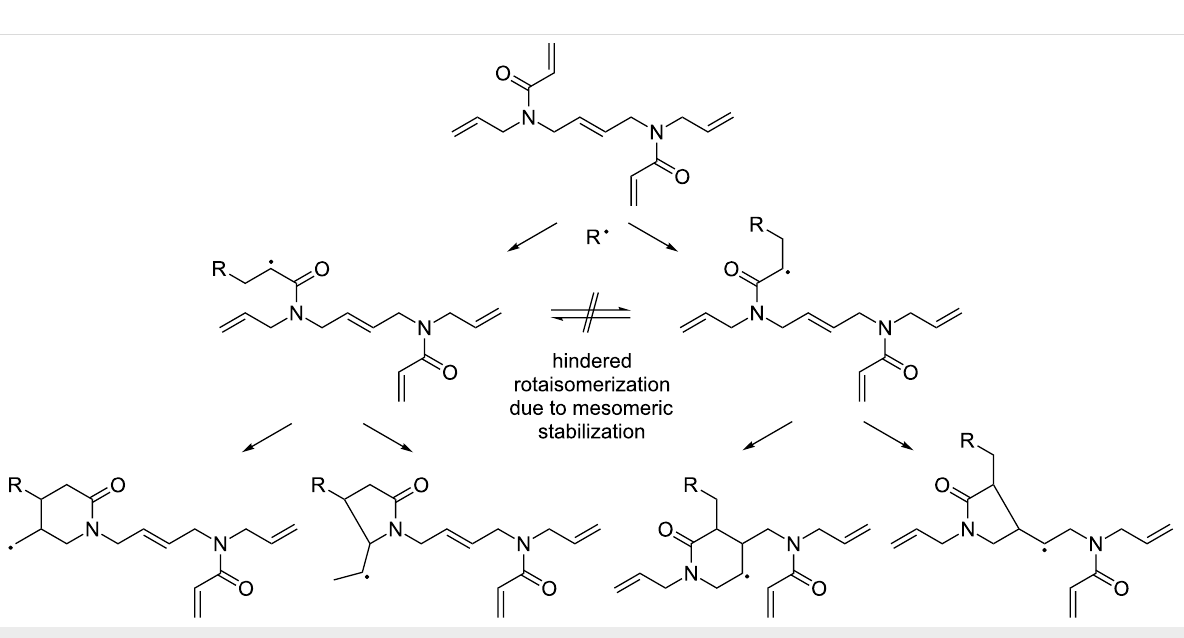
Scheme 6: Proposed reaction pathways for the intramolecular propagation within 1